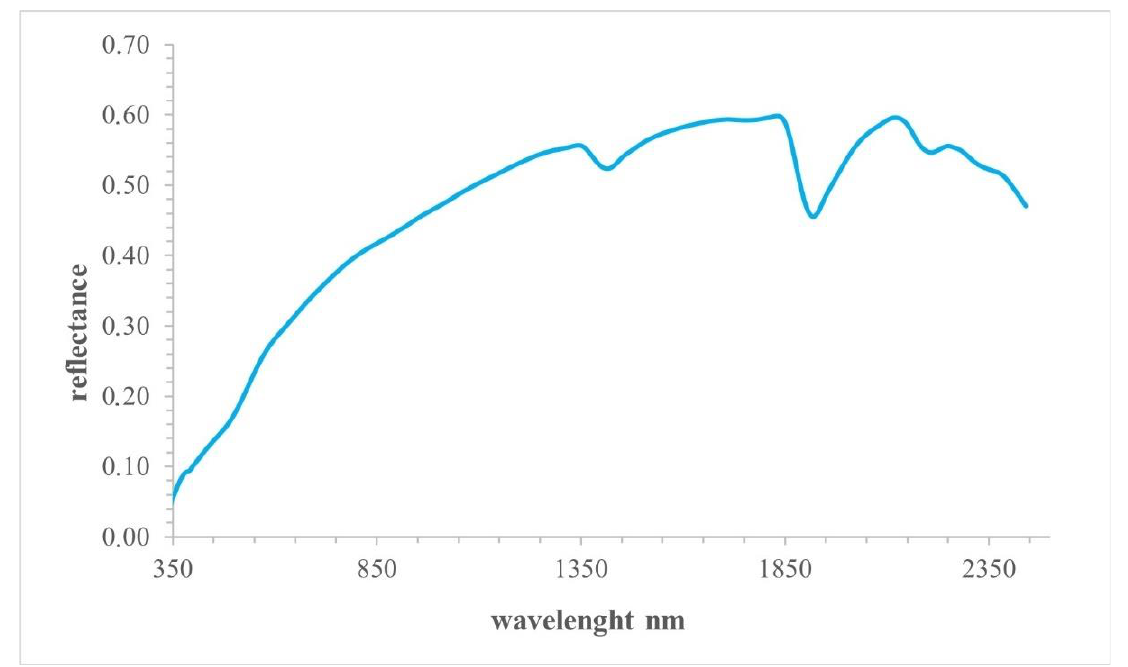
Figure 4. Reference reflectance spectrum for the calculation of SID-SAM.